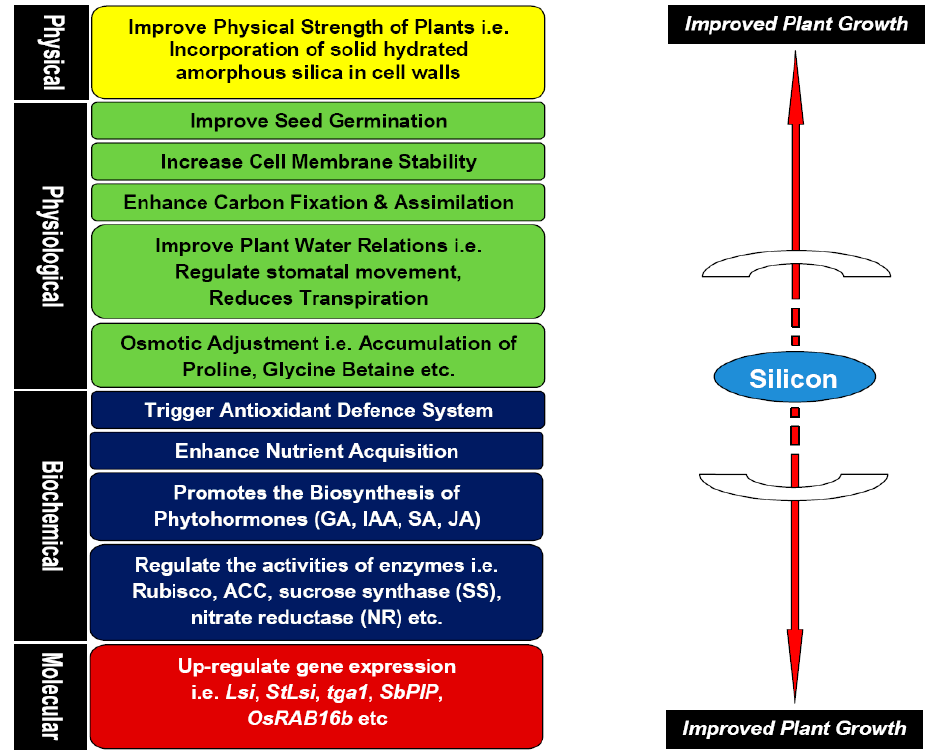
Figure 4. Various mechanisms of Si-mediated water-deficit tolerance in plants.